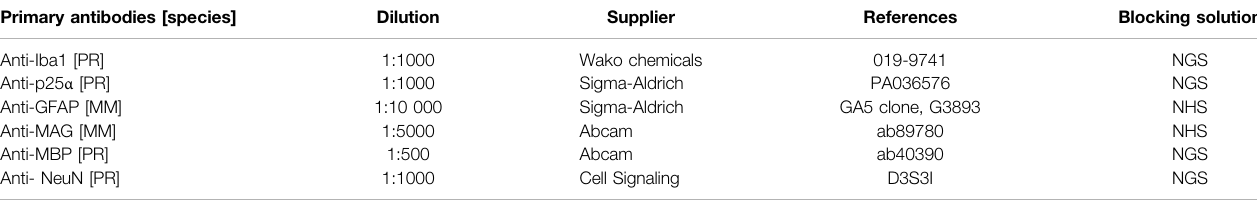
TABLE 1 | Primary antibodies used for